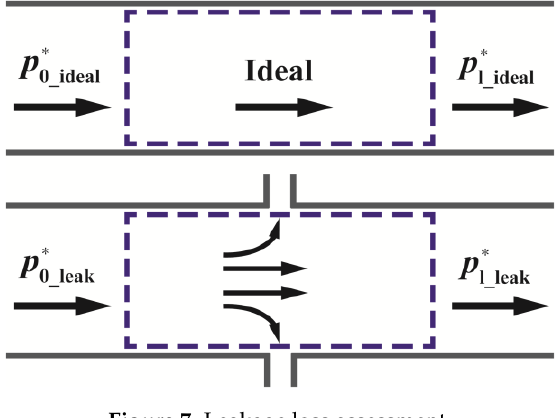
Figure 7. Leakage loss assessment.